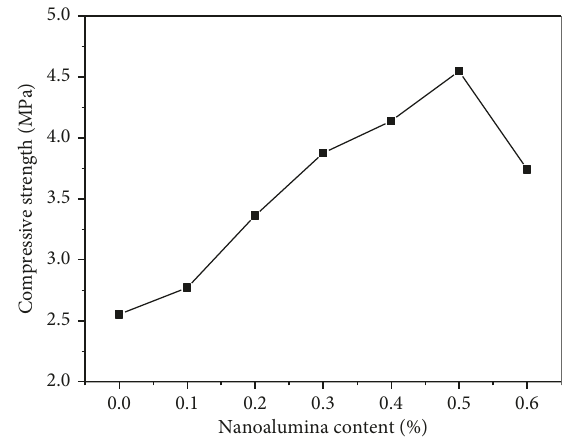
Figure 7: Compressive strength of the OD/EP gypsum sample with nano-Al 2 O 3 .